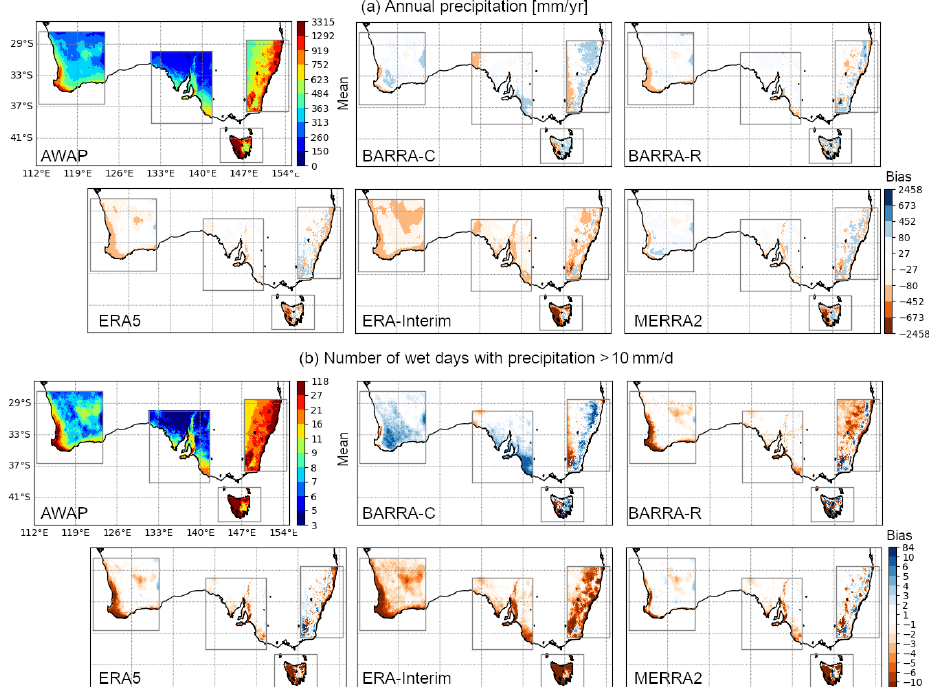
Figure 7. Mean difference in (a) annual precipitation and (b) annual count of wet days with depth ≥ 10mm. The models are regridded onto the AWAP grid using nearest-neighbour